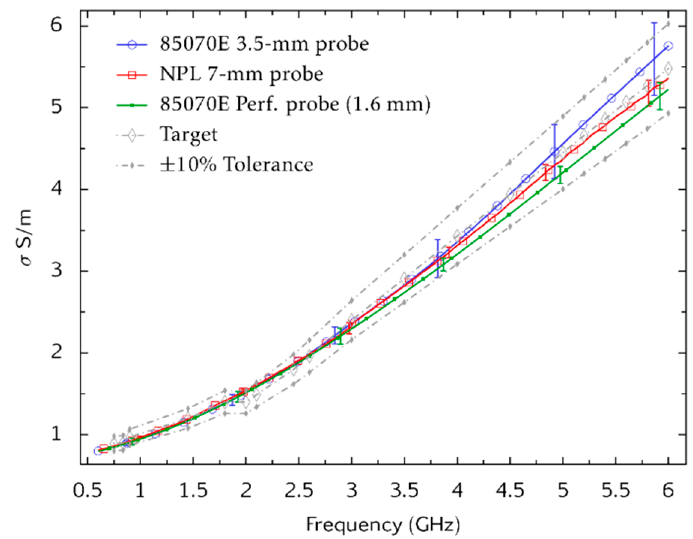
Figure 7. Inter-laboratory comparison of tissue-equivalent liquid dielectric properties. Measurements of the dielectric properties ε ’ ( top ) and σ ( bottom ) are shown. Uncertainties for the 85070E probes are taken from the manufacturer’s specification. Combined Type A and Type B uncertainty for the National Physical Laboratory (NPL) 7 mm probe was evaluated by Monte-Carlo modelling [20]. The observed Type A uncertainty associated with measurements made by using the 85070E probes are also plotted. All uncertainties are presented at a coverage factor of k = 2 (equivalent to 95% confidence level).